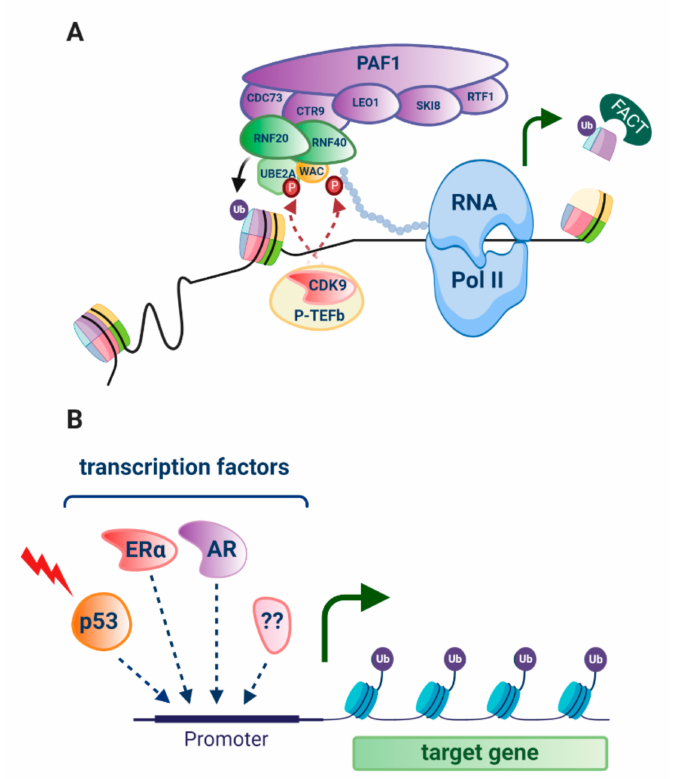
Figure 2. H2Bub1 in transcriptional elongation. ( A ) Following stimuli such as DNA damage, hormones or developmental signals, cyclin-dependent kinase 9 (CDK9) that is part of the Positive Transcription Elongation Factor-b (P-TEFb) complex phosphorylates Ser2 in the carboxy-terminal domain of RNA polymerase II (RNA pol II) depicted by a chain of circles, as well as the E2 ubiquitin conjugating enzyme ubiquitin conjugating enzyme E2 A (UBE2A). This dual phosphorylation shown by red circles, establishes a binding domain for the WW domain-containing adaptor with coiled-coil (WAC) and the E3 ubiquitin ligase complex RNF20 / RNF40 that monoubiquitinates histone H2B at lysine 120